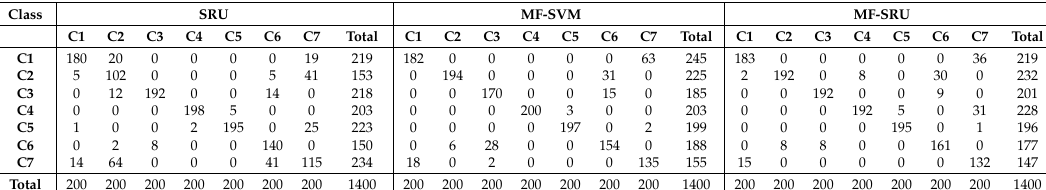
Table 2. Comparison of the confusion matrices.